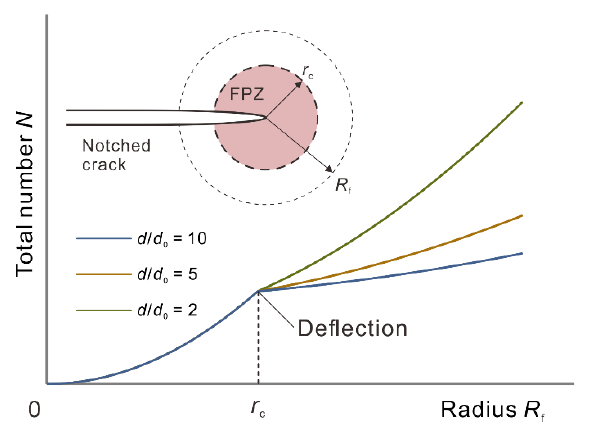
Figure 12. Variation trend of total micro-crack number inside tip-centered circles with various radii R f . The three curves correspond to cases under different ratios of d / d 0 .